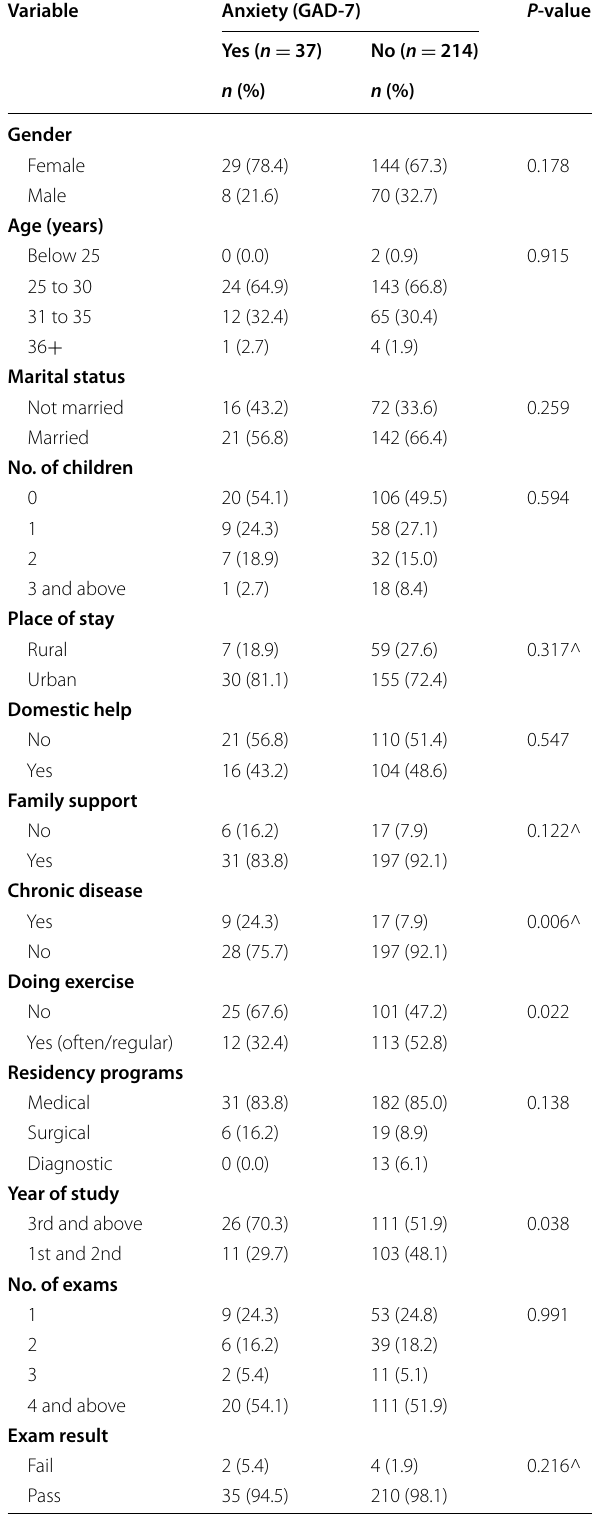
Table 2 Univariate analysis for anxiety in the association of socio‑demographic and occupational variables